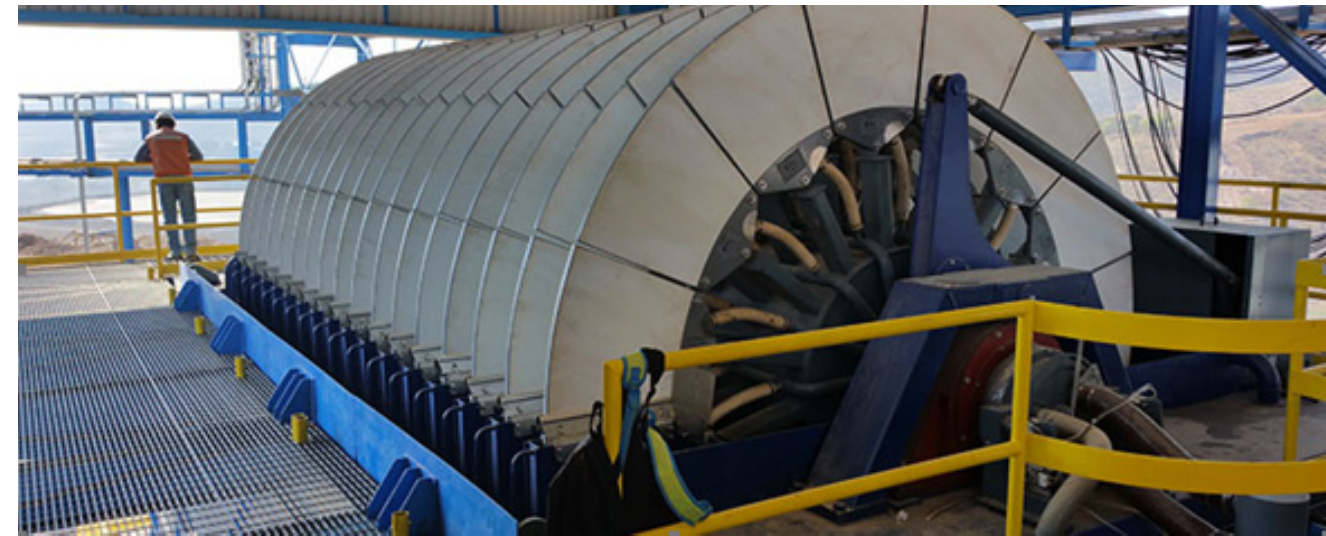
Figure 3. Typical Tailings Ceramic Disc Filter [15].